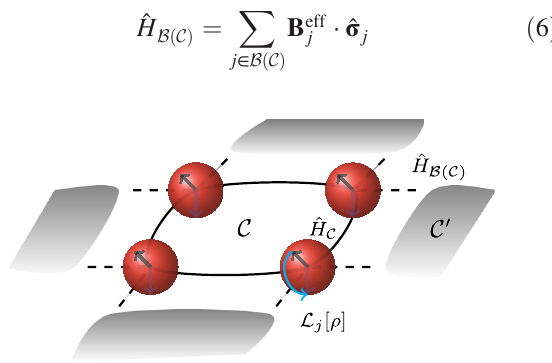
FIG. 2. Sketch of the cluster mean-field approach in a dis- sipative system of interacting spin- 1 = 2 particles. The figure refers to a 2 × 2 cluster on a two-dimensional square